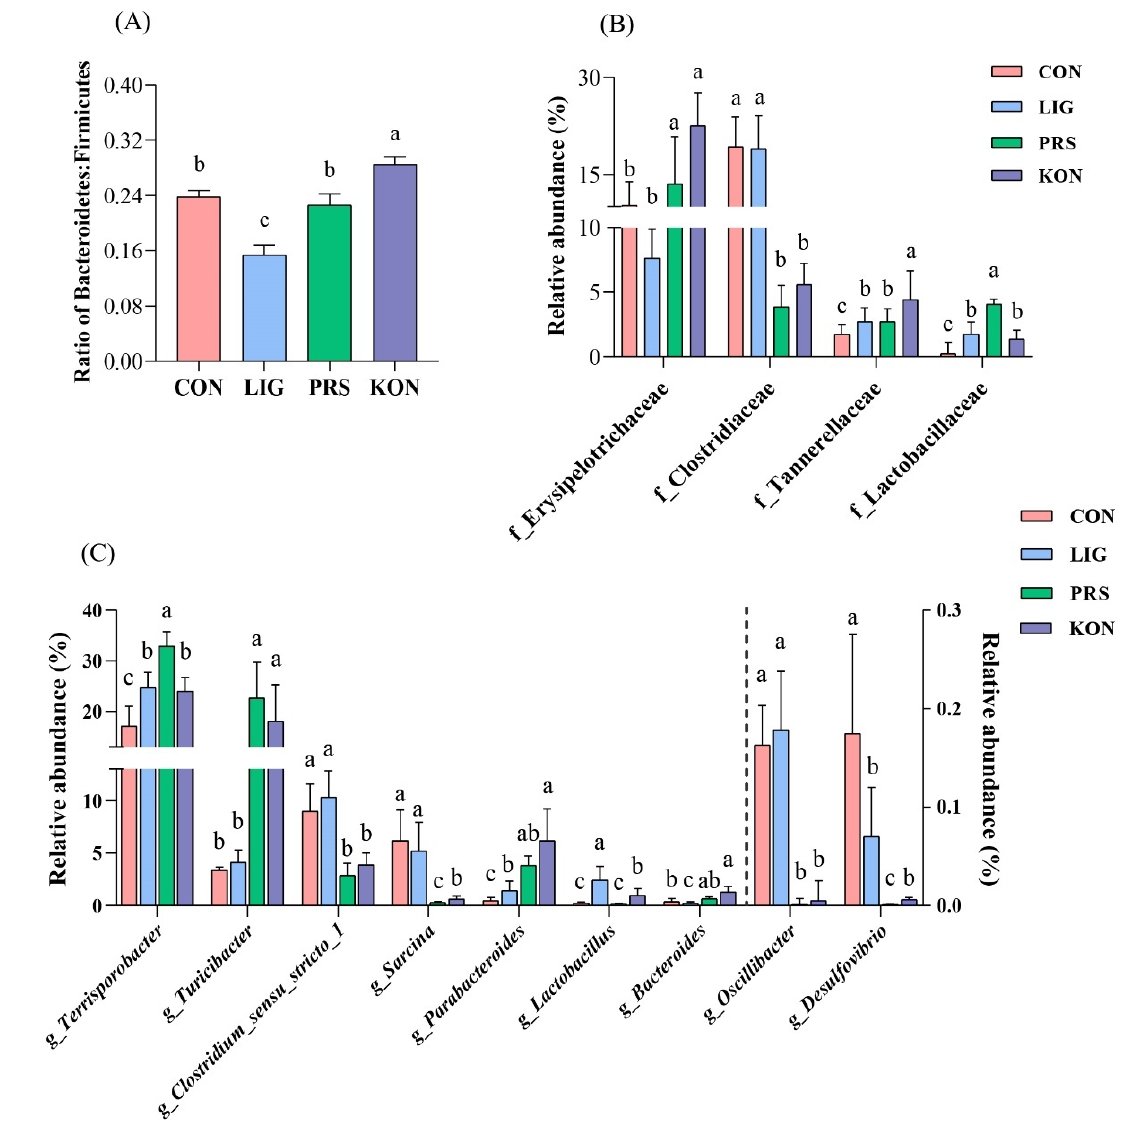
Figure 5. Differential microbial analysis of the feces of late pregnant sows ( n = 7). The ratio of Bacteroidetes to Firmicutes ( A ), and differential microbial analysis at the family level ( B ) and genus level ( C ) between CON and PRS. CON, control; LIG, lignocellulose; PRS, resistant starch; KON, konjaku flour. Differences in superscript letters for the peer data indicate that the difference is significant ( p < 0.05).